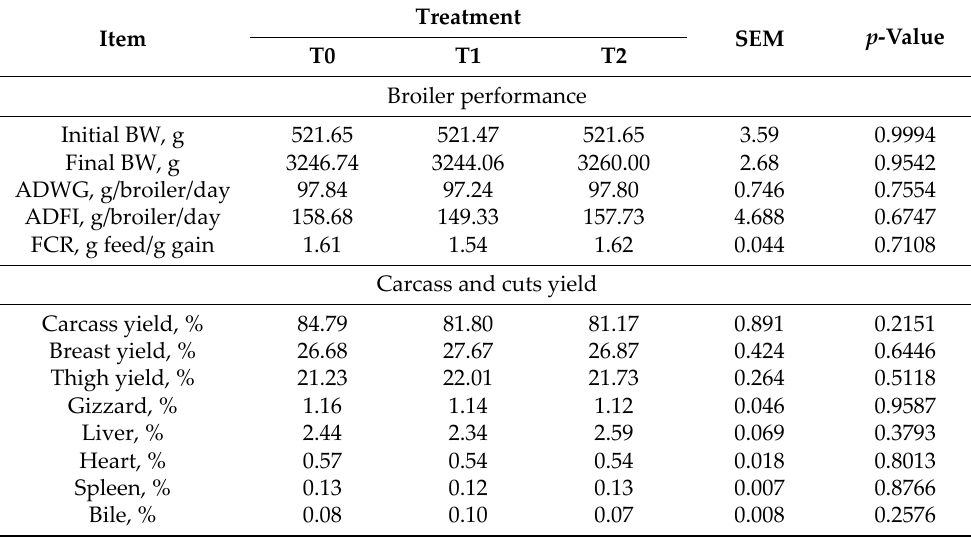
Table 3. Treatment effects on broiler performance and carcass and cuts yield.